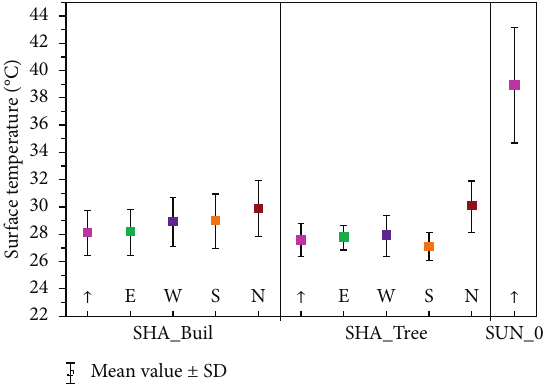
Figure 3: Surface temperature of the solid surfaces at different positions around the research